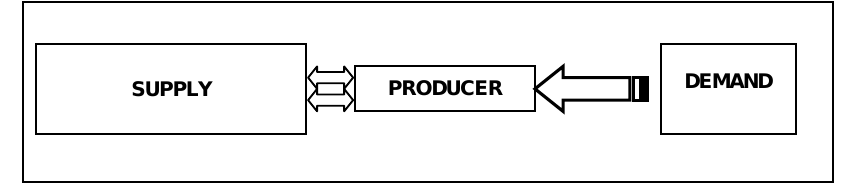
Figure 1: Localization Choices in Low-Demand